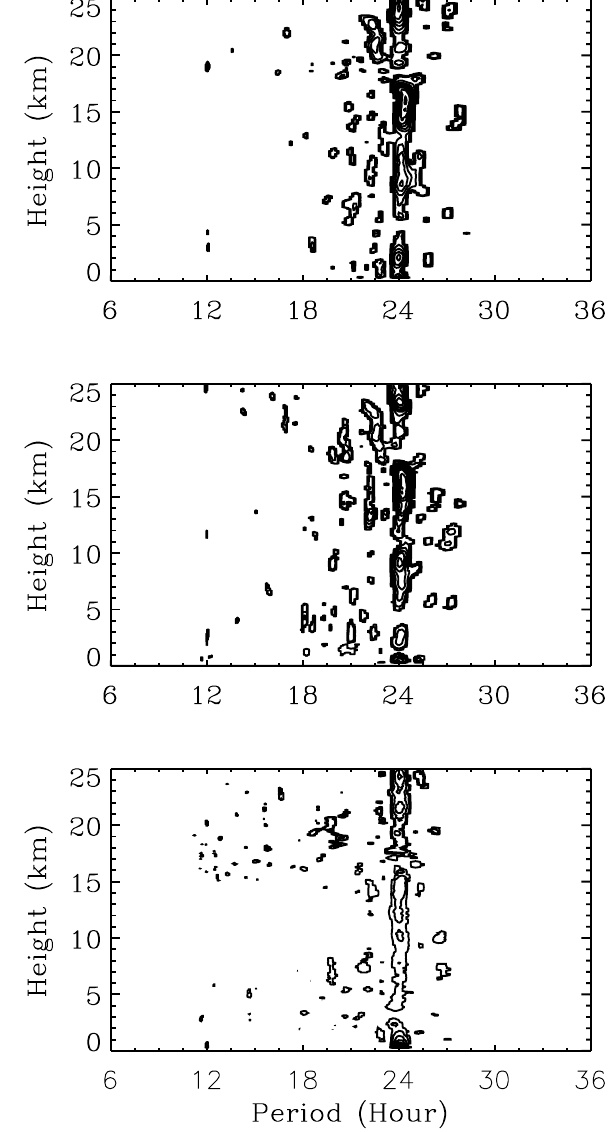
Fig. 4. Lomb-Scargle periodogram of high-pass filtered zonal wind (top), meridional wind (middle), and temperature (bottom) distur- bances in August 2006. Only the values with confidence levels greater than 95% are shown. The minimum values and the inter- vals of the contours for the zonal wind are all 0.2ms − 1 , for the meridional winds are all 0.25ms − 1 , and for the temperature are all